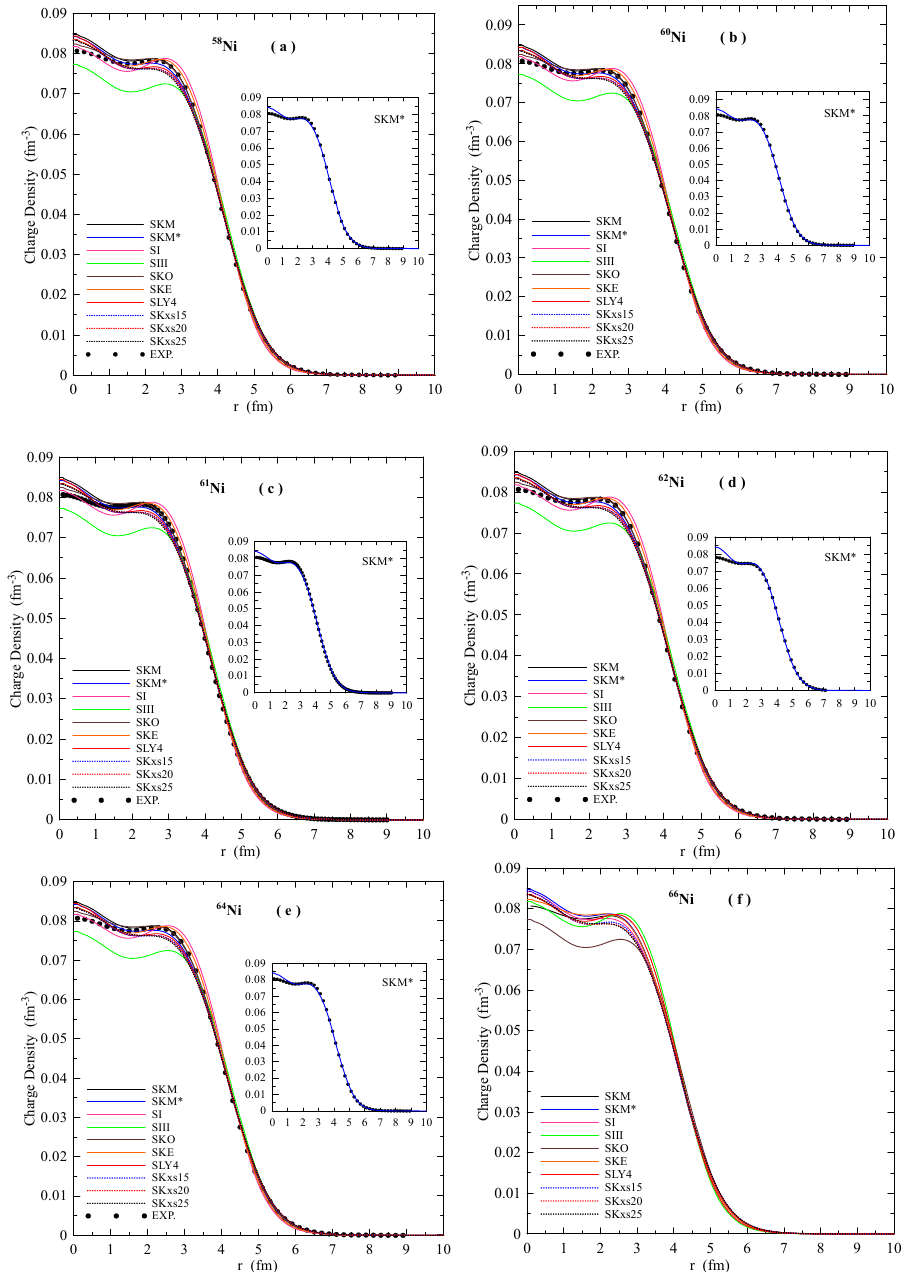
Fig. 2: Calculated charge density distributions for 58-64 Ni isotopes. The inset figures are embedded to show the agreement between the calculated CDD with SKM* parameterizations and experimental data. The experimental data are taken from Ref.